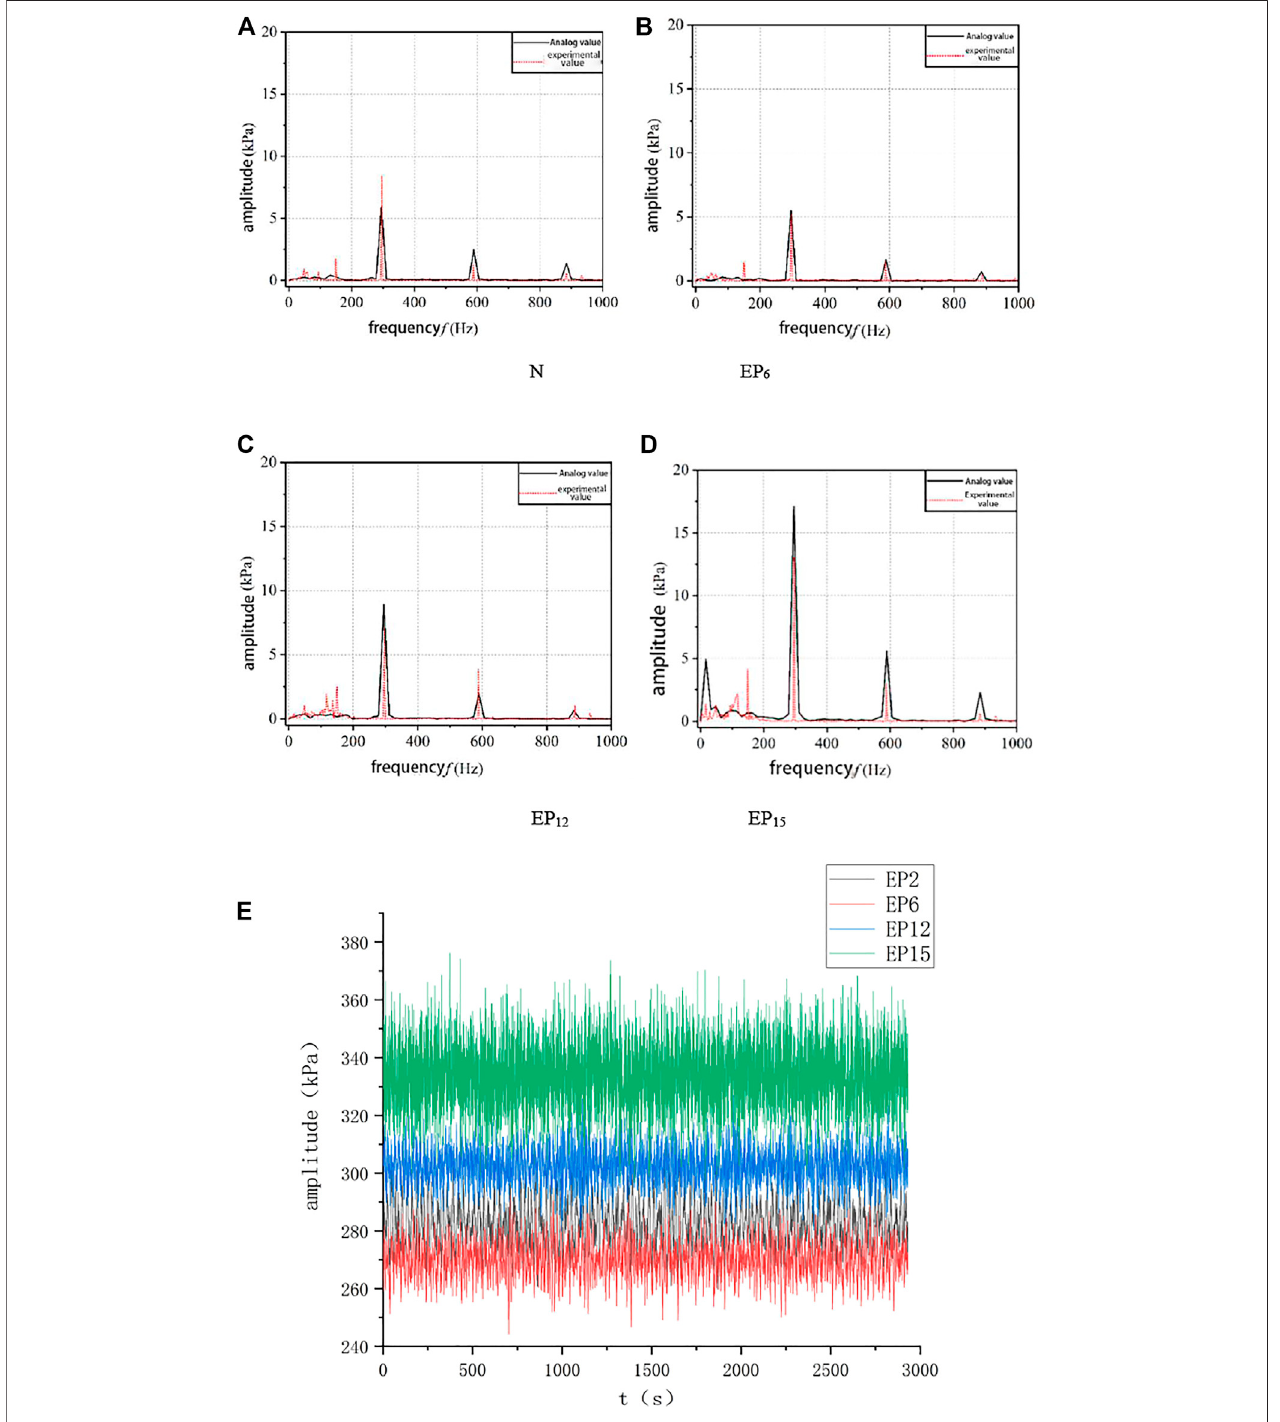
FIGURE 8 | Comparison of experimental value and calculation results of pressure pulsation of the prototype pump (IA90) at different observation points under design conditions and the original pressure signal.